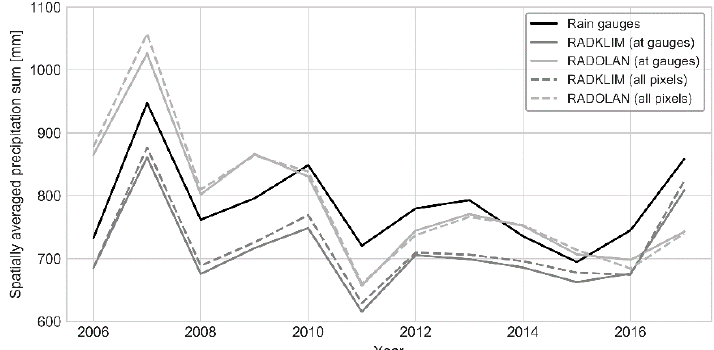
Atmosphere 2020 , 11 , x Figure 4. Mean annual precipitation sums of Germany between 2006–2017. Figure 4. Mean annual precipitation sums of Germany between 2006–2017. Figure 4. Mean annual precipitation sums of Germany between 2006–2017.